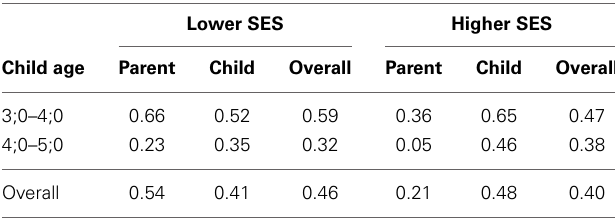
Table 2 | Proportion of child name associations out of all letter–word associations in analysis 2, by SES, speaker, and child